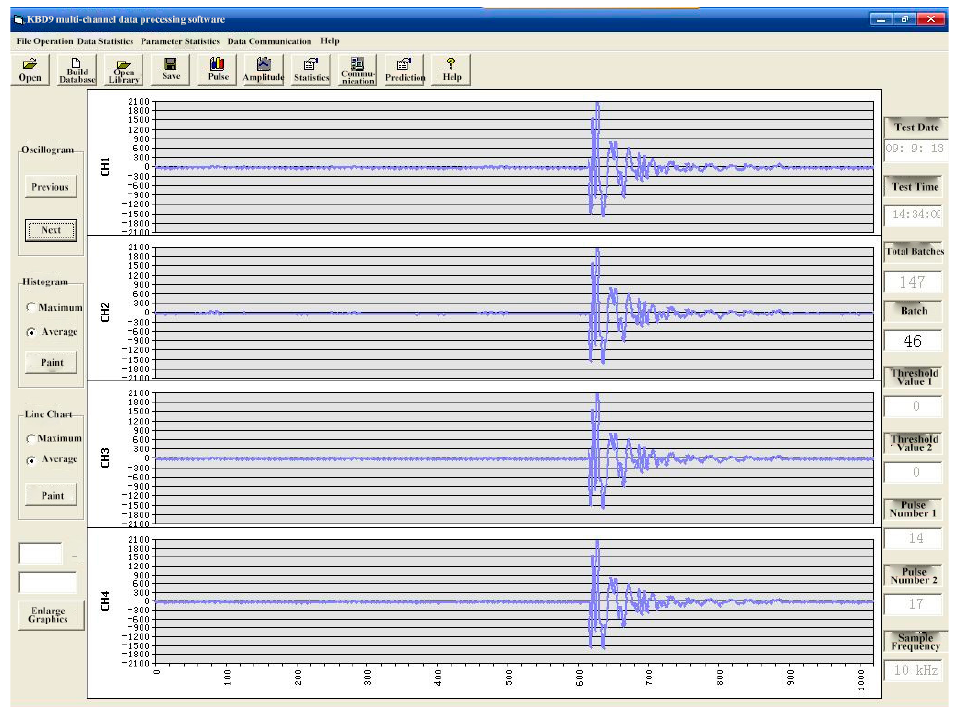
Figure 4. Main interface of data processing software in Chinese.